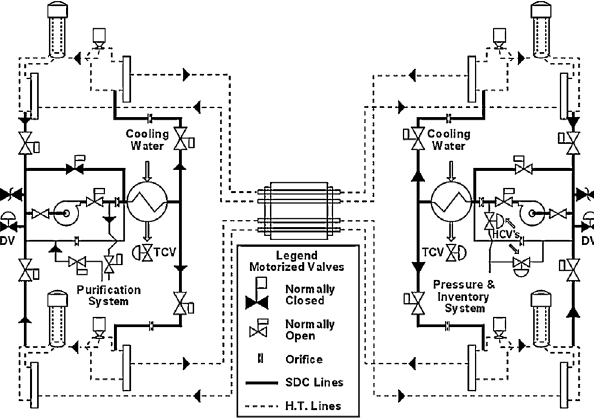
Fig. 1. Simpli fi ed network of SDCS coupled with PHTS.